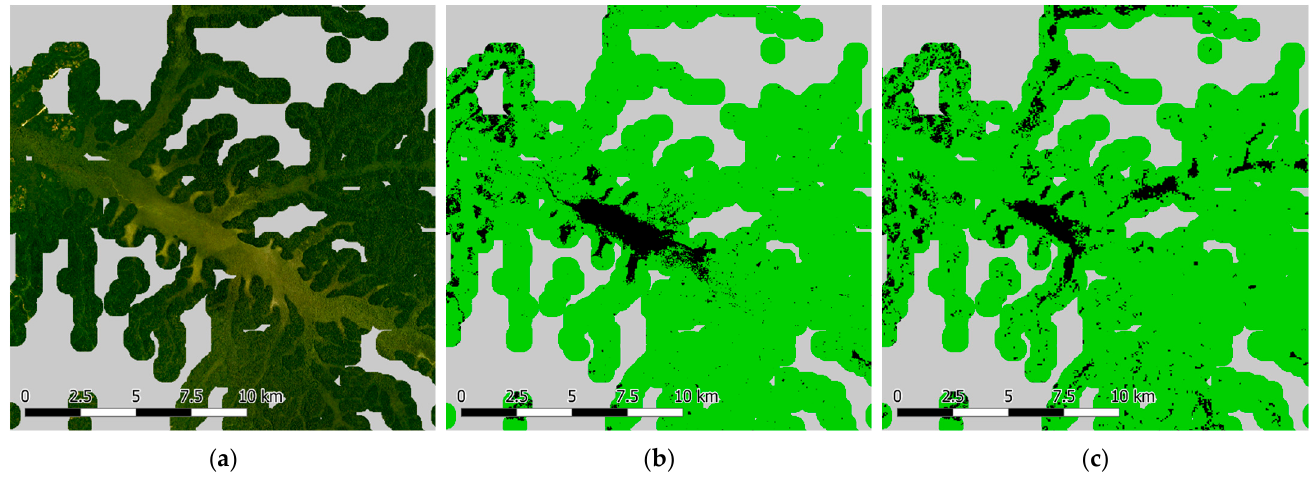
Figure 1. A comparison of: ( a ) a true-color, optical image from PlanetScope [18]; ( b ) the optical-based Global Forest Change product [1]; and ( c ) the radar-based FNF mask from German Aerospace Centre (DLR) [14]. The Global Forest Change loss product for 2000–2019 [1] was used in ( b ) and ( c ) to exclude areas that were deforested in that period. The area is in Eastern Gabon (14.0683 E, 0.9783 N). The area is masked to only show (buffered) wetland pixels; the others are grey. Pixels classified as forest are shown in green; non-forest areas are shown in black.